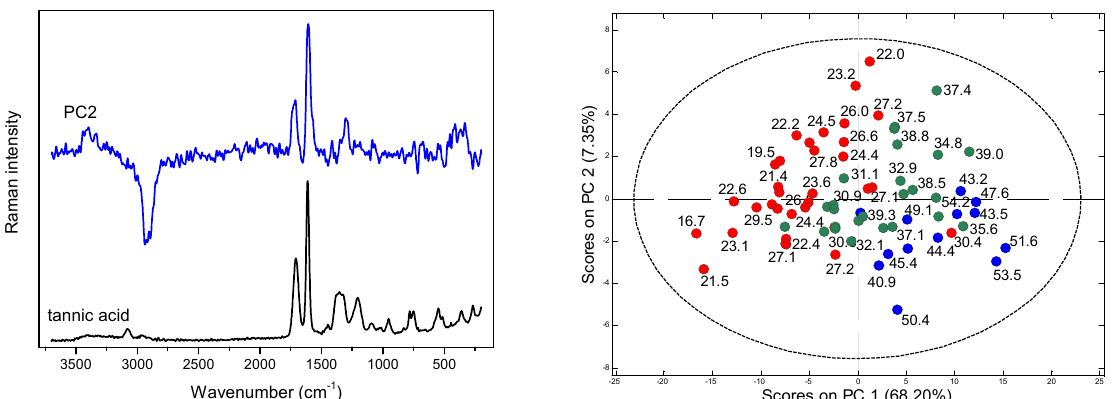
Figure 3. PC2 loadings and Raman spectrum of tannic acid ( left ); scores plots for Raman data with the values of TF ( right ); red points indicate samples containing TF below 30 mg ME/g d.w., green—TF in the 30–40 mg ME/g d.w. range, and blue—TF content above 40 mg ME/g d.w.